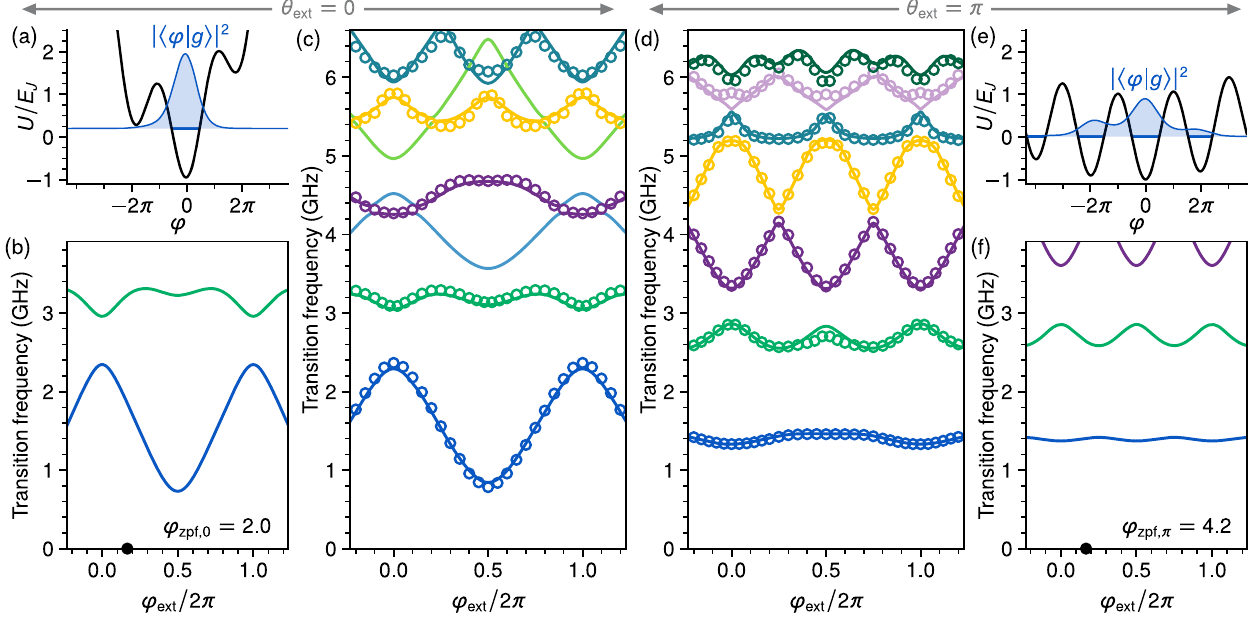
π = 3 ext ¼ 0 and half flux θ π . (b),(f) Lowest-lying transition frequencies of the ext ¼ ext ¼ 2 . 0 to φ 4 . 2 . (c),(d) Two-tone measurements of the transition zpf ; 0 ¼ zpf ; π ¼ is stepped from 0 to π ext